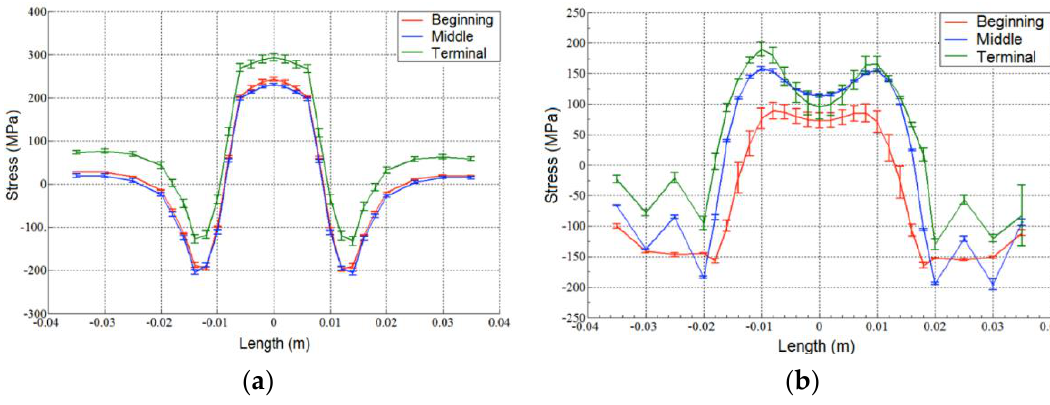
Figure 12. Transverse residual stresses located at the beginning, middle and end, after the first simulated welding pass until cooling to room temperature ( a ); and after two simulated welding passes until cooling to room temperature ( b ).